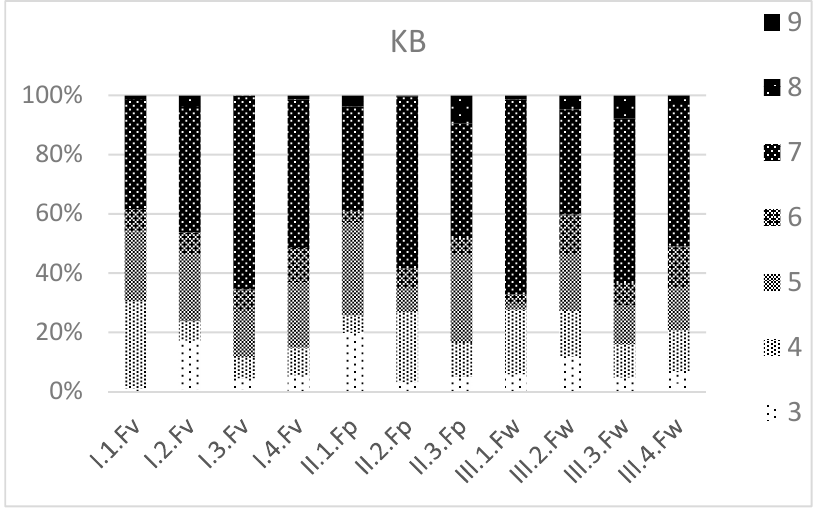
Figure 5. Proportion of the taxa based on their ability to tolerate extreme climatic effects. KB: continentality. Festuca vaginata vegetation types: I.1.Fv: Little Hungarian Plain, I.2.Fv: northern part of Kiskunság, I.3.Fv: southern part of Kiskunság, I.4.Fv southernmost part . Festuca pseudovaginata